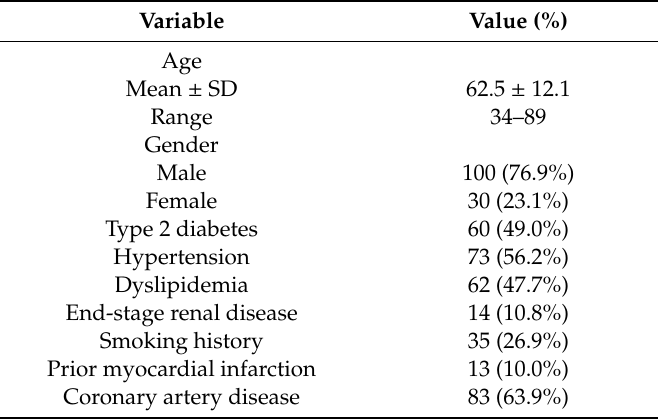
Table 1. Clinical characteristics of 130 patients in this